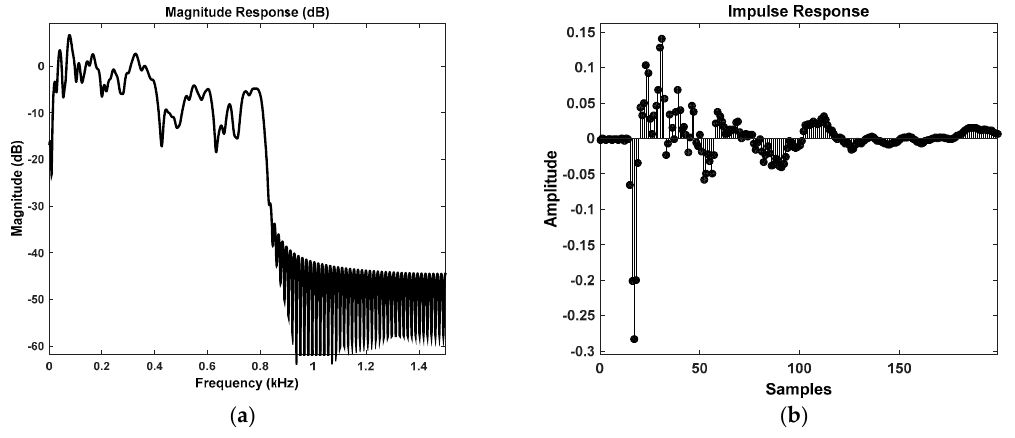
Figure 14. Transfer function S ( z ) of the secondary path and impulse response s ( n ) of the secondary path. ( a ) Transfer function; ( b ) Impulse response.